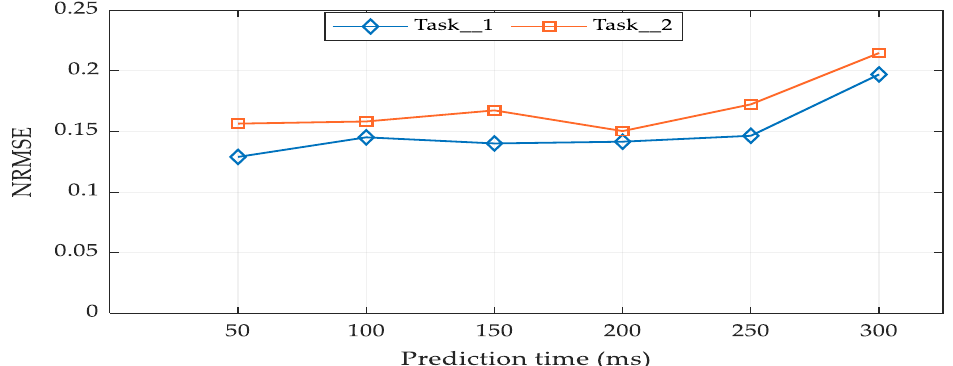
Figure 12. Impacts of speed and tasks on prediction performance. ( a ) Performance in terms of CC index; ( b ) performance in terms of NRMSE index.